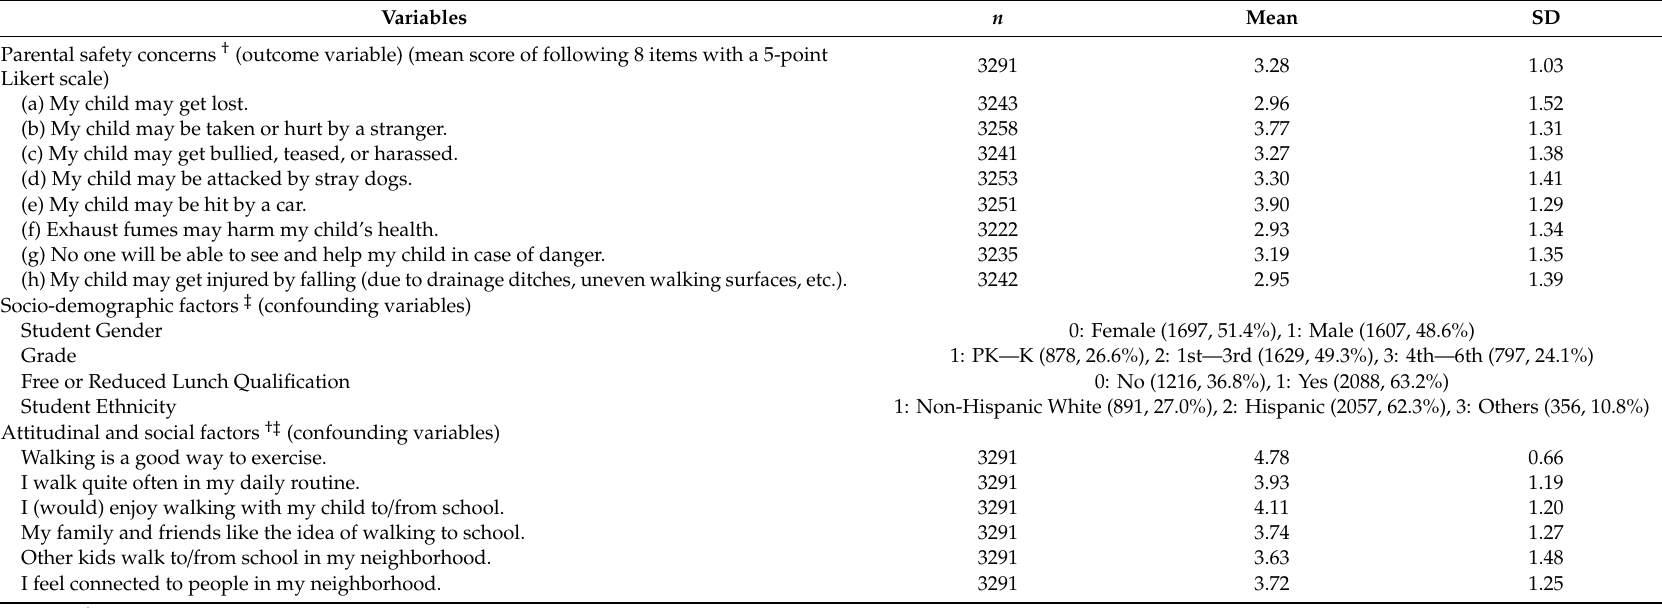
Table 1. Descriptive statistics of outcome variable and confounding